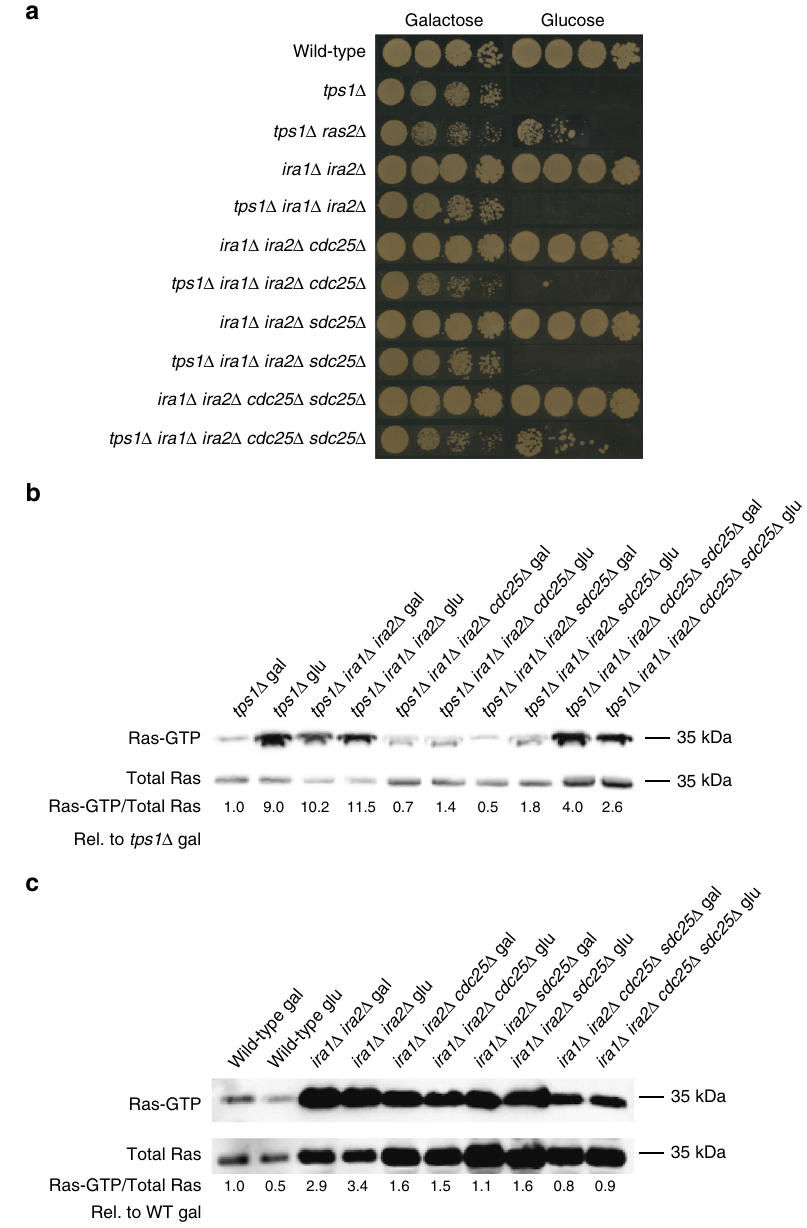
Fig. 5 Evaluation of requirement for the GEF and GAP regulators of Ras. a Growth on galactose and glucose. Five-fold dilutions were spotted. b , c Ras-GTP level before and 10 min after addition of glucose (glu) to cells grown on galactose (gal). Quanti fi cation of the signals as Ras-GTP level/total Ras level compared to the ratio for wild type ( b ) or tps1 Δ ( c ) on galactose set at 1.0. The values were determined through quanti fi cation by densitometry and are expressed as relative arbitrary signaling 28 . The inability to detect a decrease in the cytochrome c content of the mitochondria in the tps1 Δ strain concomitant with the appearance of cytochrome c in the supernatant, is likely due to the fact that the amount appearing in the supernatant is much smaller than the amount remaining in the mitochondria.